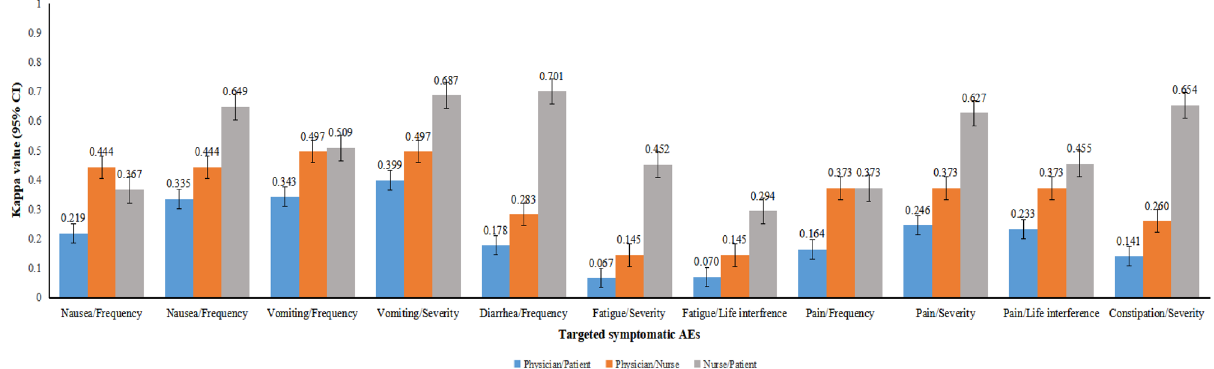
Figure 2. Consistency analysis among nurses, physicians, and patients according to toxicity grade (95% CI).